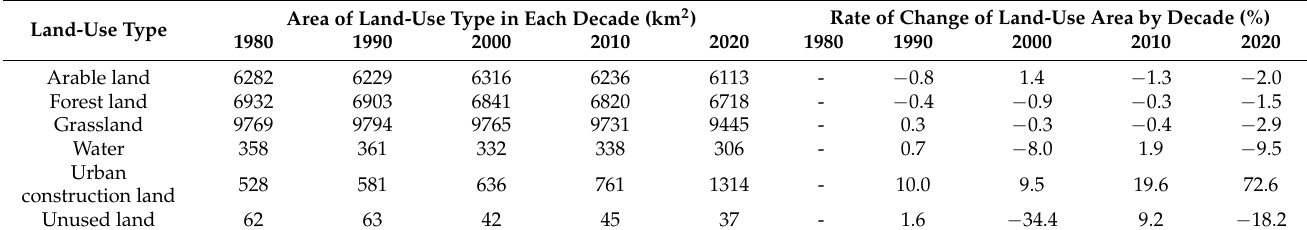
Table 6. Land-use area and year-on-year changes in the Hutuo River Basin above the Huang- bizhuang Station.